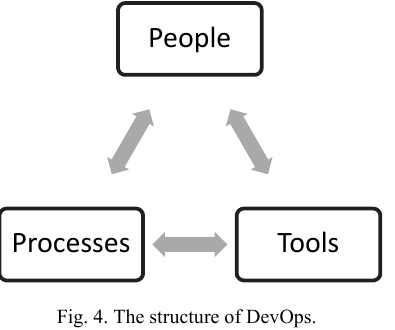
Fig. 4. The structure of